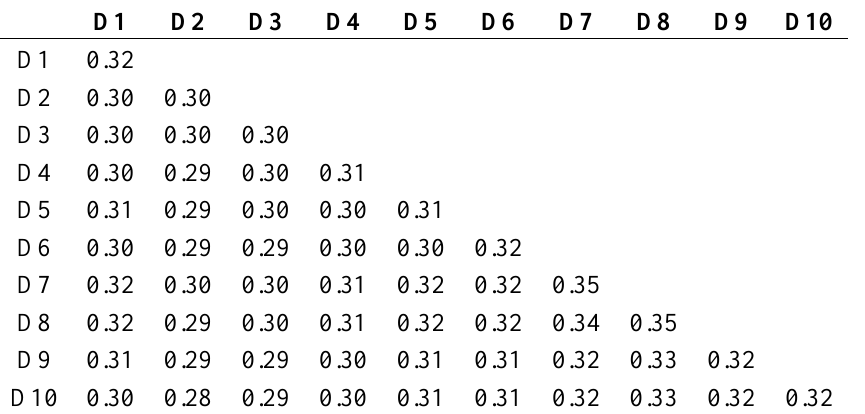
Table A2. Flow-decile covariances, small-cap equity